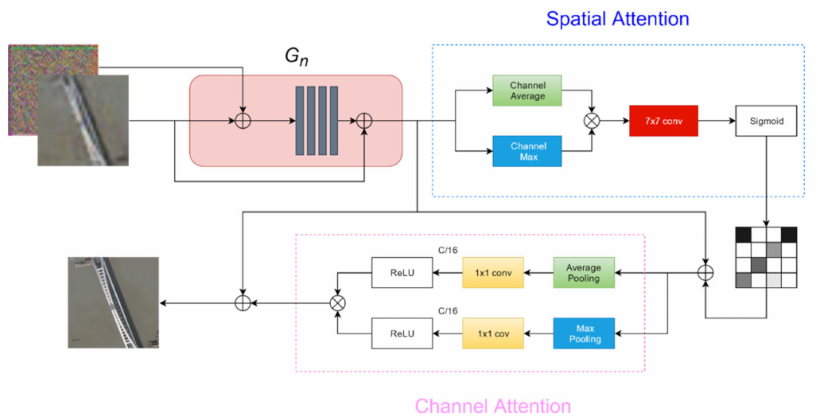
Figure 6. Framework structure of the Generator of the proposed improved